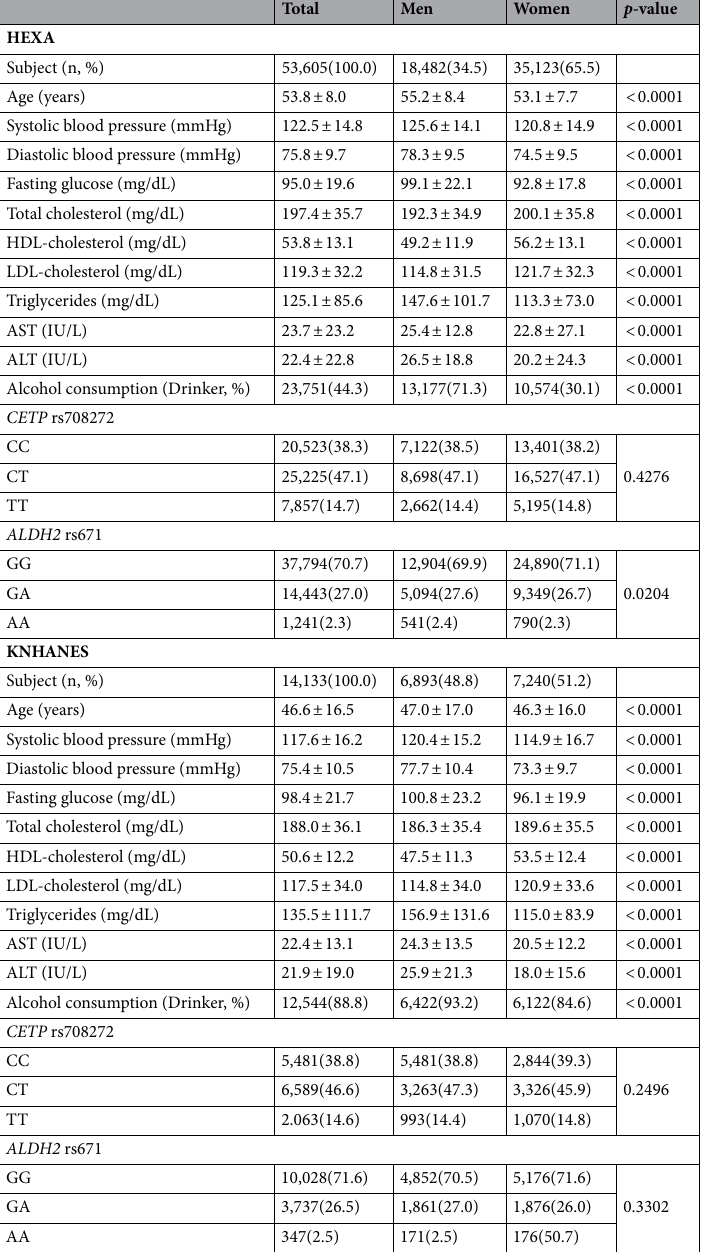
Table 1. General characteristics of Korean population. All data except alcohol consumption, CETP and ALDH2 genotype are represented as means ± standard deviation. Student’s t-test and chi-square tests were used to determine differences between men and women. HDL high-density lipoprotein, AST aspartate aminotransferase, ALT alanine